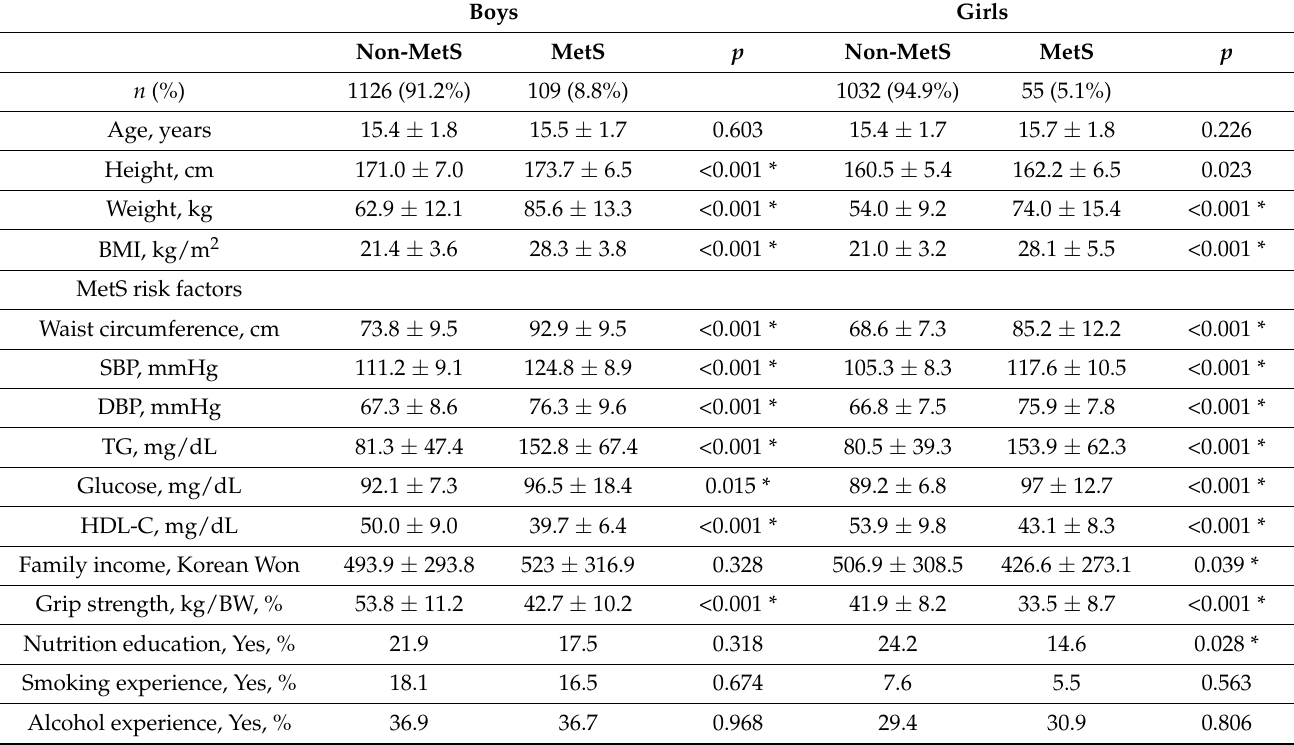
Table 2. General characteristics according to the prevalence of metabolic